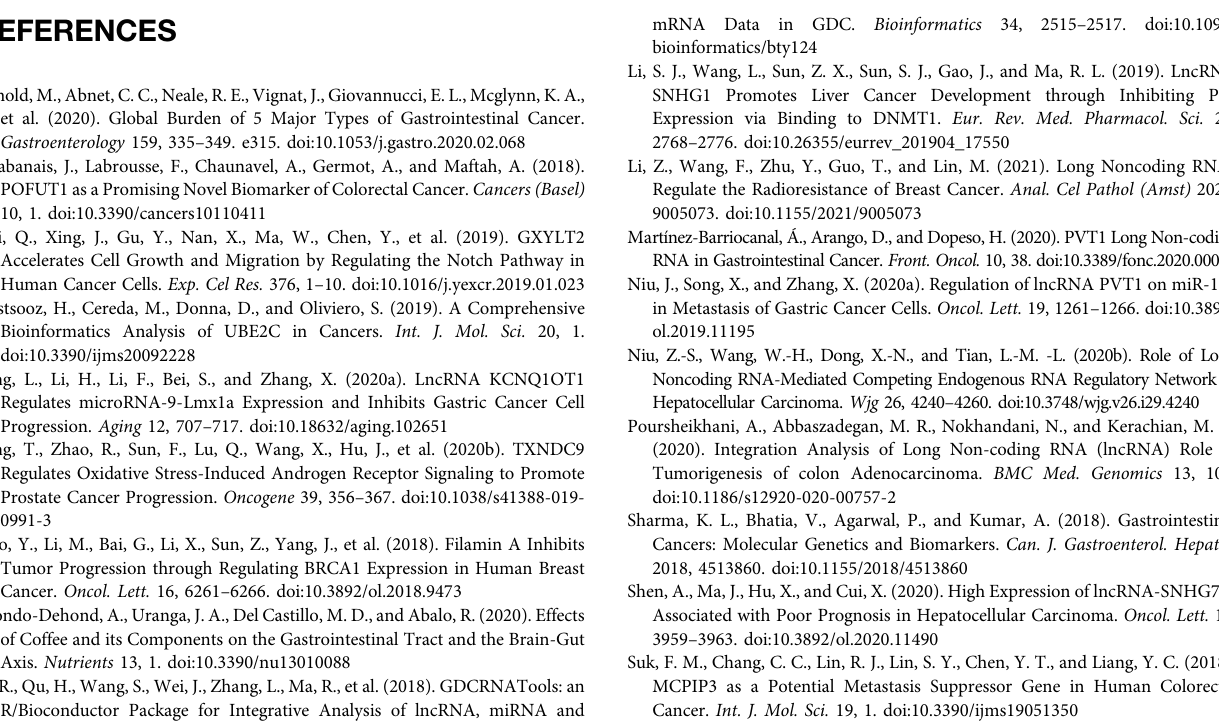
Supplementary Table S4 | The GO terms (BP, CC, and MF) and KEGG pathways involved in the TCGA-GI cancers. Supplementary Table S5 | Common GO terms and KEGG pathways of the GI cancers. Supplementary Table S6 | Speci fi c and distinct GO terms and KEGG pathways of the GI